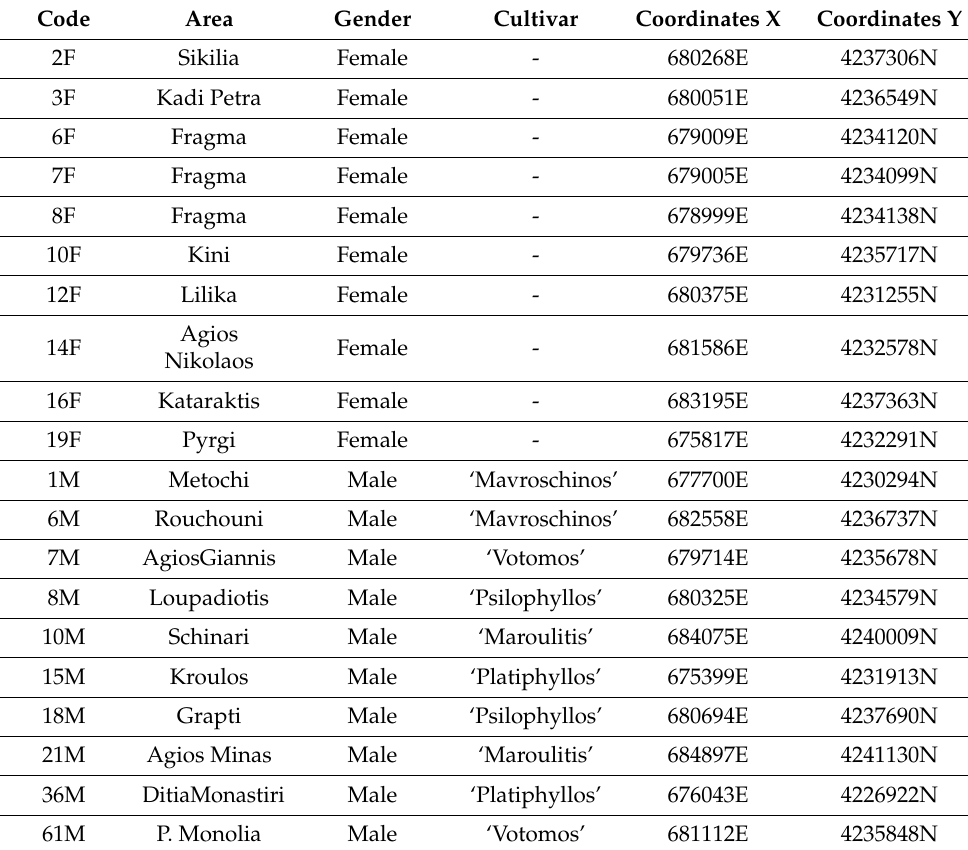
Table 1. Plant collection areas in Southern Chios Island, coding and coordinates of ten female (F) and ten male (M) selected genotypes of P. lentiscus var.